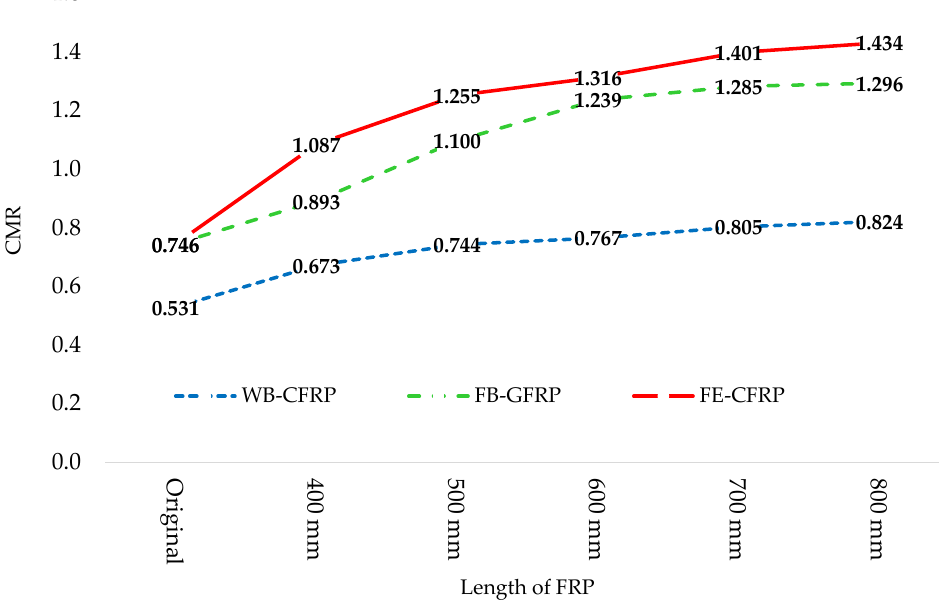
To show the impacts of the plastic hinges on the fragility capacity of frames retrofitted with different lengths from 400 mm to 800 mm, the plastic hinge distributions and their performance levels for the original and FRP retrofitted frames at the target displacement point are given in Table 10. The performance levels of the joints were obtained graphically from force–displacement capacity curves and the results are shown in Table 10. The letters B to E and notations IO (immediate occupancy), LS (life safety), and CP (collapse prevention) represent these performance states. Table 10. Number of plastic hinges in the web and flange ‐ bonding frames.